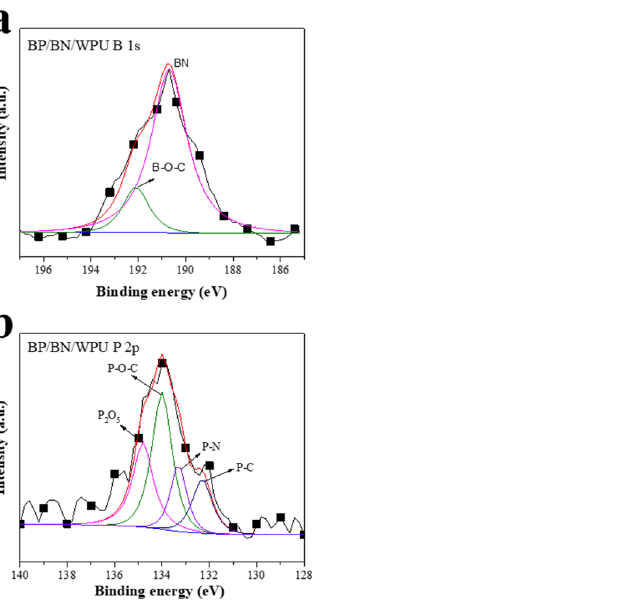
Table 3. The content of BP and BN nanosheets in the residues after the CC test.